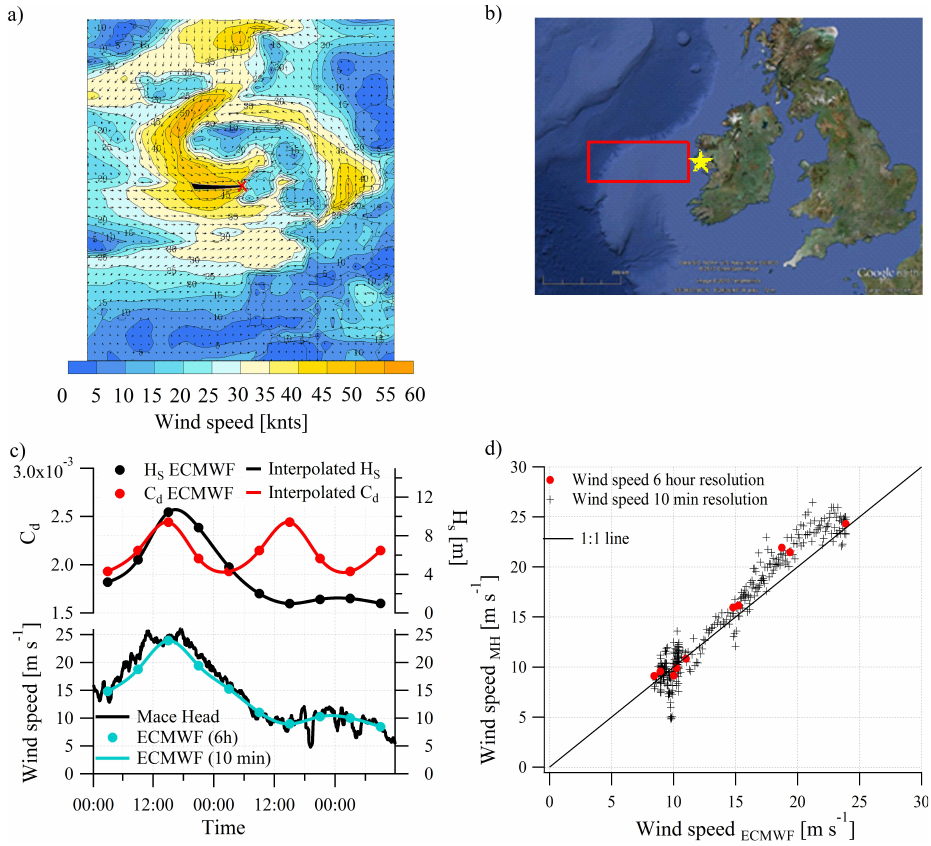
Fig. 2. (a) Wind speed field (in knots) for 12:00UTC 11 November 2010 obtained from the NOAA Air Resources Laboratory. The local wind speed of 24.1ms − 1 (46.8knots) measured at Mace Head (red cross) was in the range of upwind wind speed presented by NOAA (45–50 knots), the black line represents the 3h air mass back trajectories with the end time of 12:00UTC 11 November 2010 and at three heights: 100, 500, 1000m above the ground level; (b) map of Mace Head location (a yellow star); the red rectangle indicates the area over which the ECMWF parameters were averaged; (c) Time series of wind speed measured at Mace Head (MH) and wind speed and wave parameters modelled by ECMWF: H s – significant height of wind waves, C d – drag coefficient due to wind waves used for Re H calculations; markers represent original 6h ECMWF resolution, lines represent the interpolated data to obtain the higher time resolution used for the parameterization. (d) Wind speed measured at Mace Head vs. ECMWF modelled wind speed over the area upwind to Mace Head (red area in (b) ). Red circles represent the original ECMWF resolution and averaged Mace Head measurement, black crosses – 10min measurement averages vs. interpolated ECMWF data.